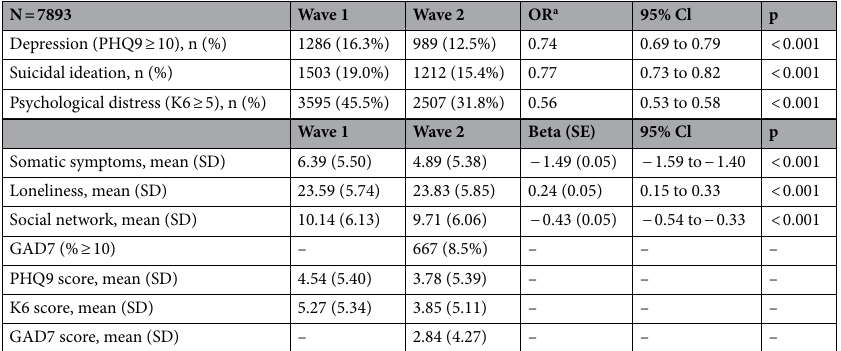
Table 2. Changes in outcome variables over waves 1 and 2 with odds ratios, betas, and 95% confidence interval. a Reference group: wave 1. CI confidence interval; OR odds